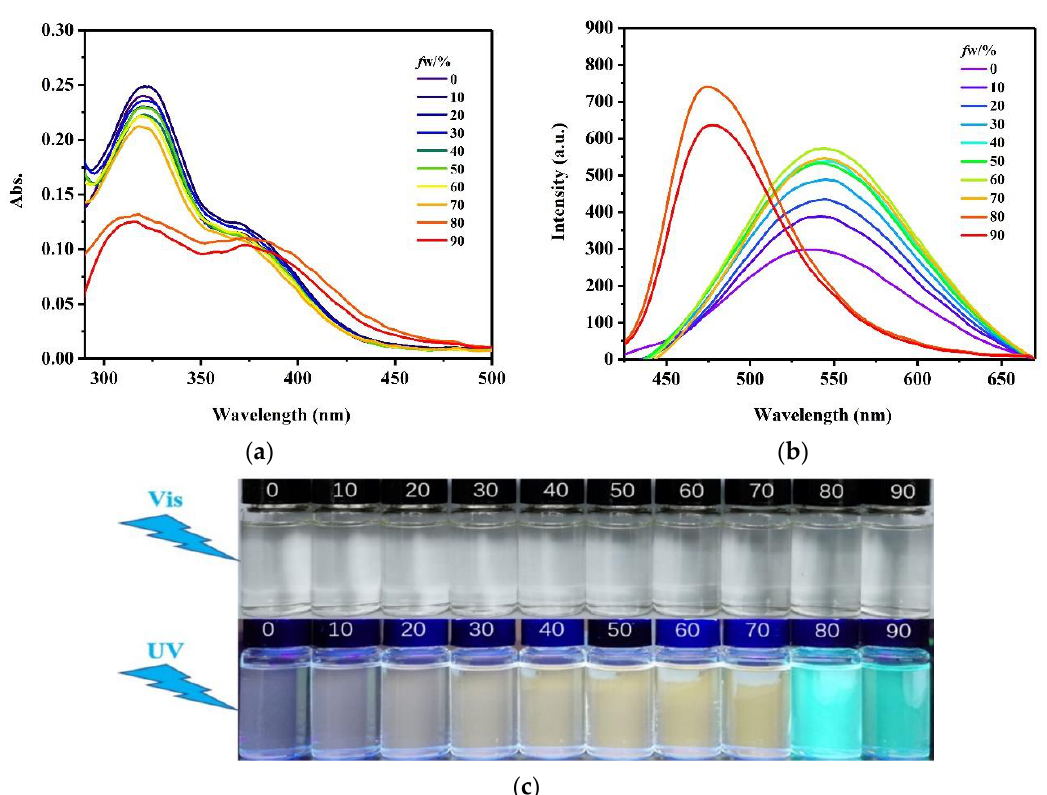
Figure 1. UV – Vis absorption ( a ) and fluorescent emission ( b ) spectra and their visual photograph ( c ) for compound TPE4A with different f w in their THF/water solutions with the same concentration of 10 µM.